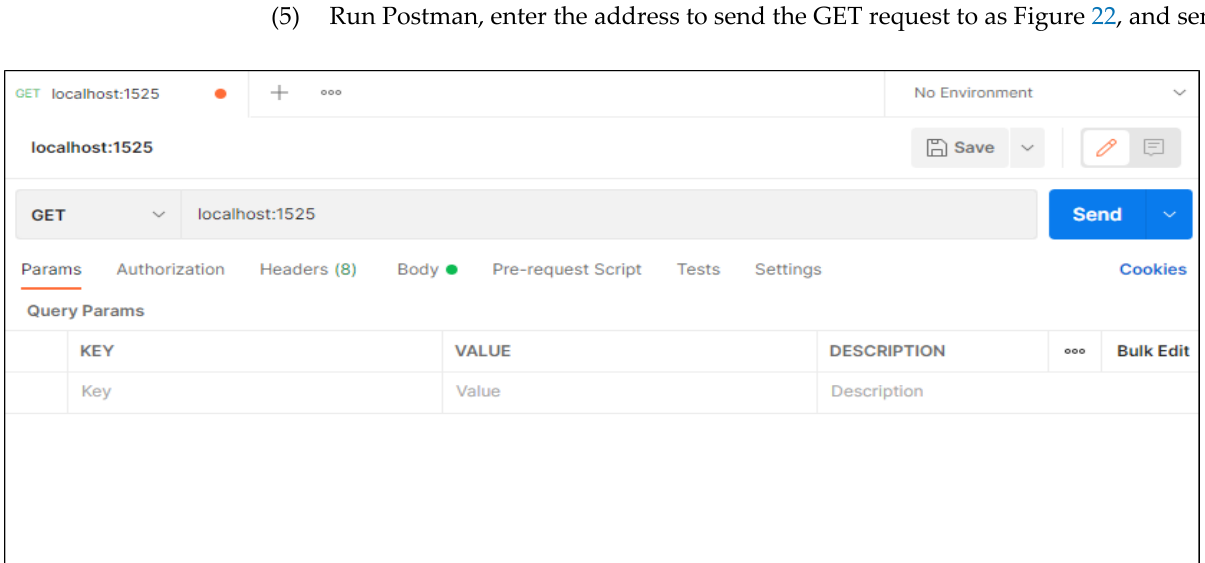
Figure 22. Screenshot of data request by using POSTMAN.